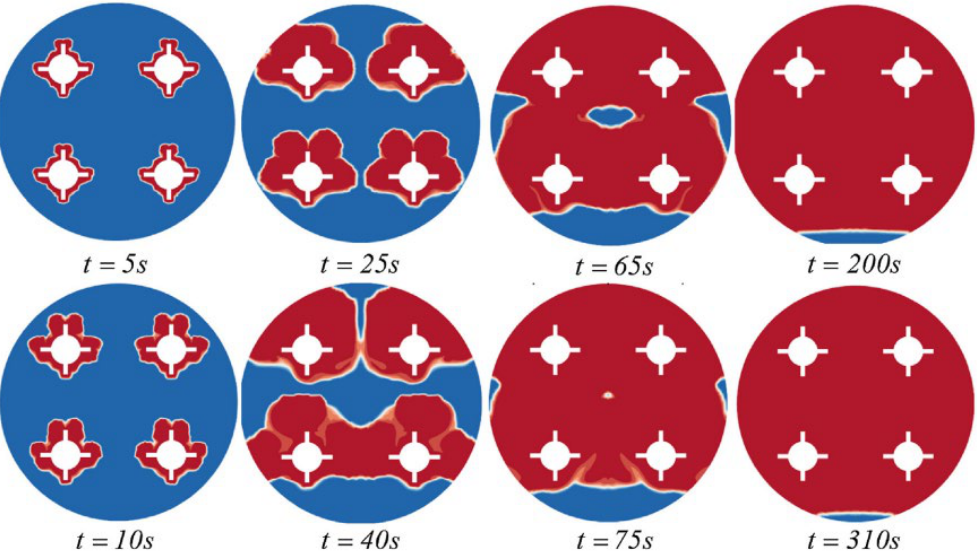
Figure 8. Development of the liquid fraction of heating sources with fins (Th = 40 °C). Reprinted with permission from Ref. [22]. 2018, Elsevier.